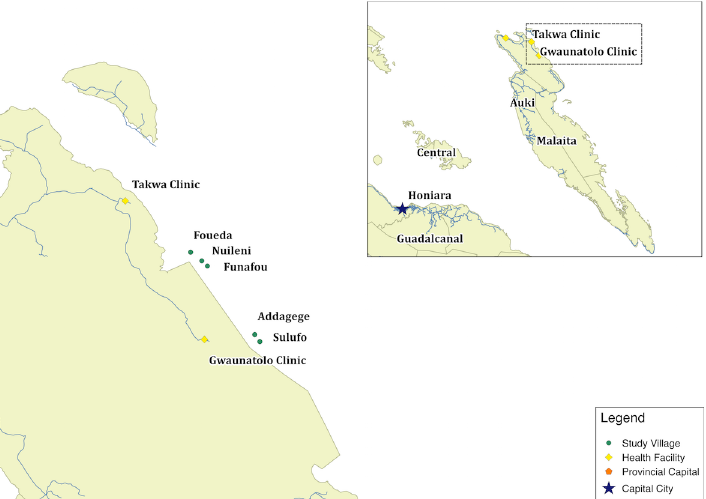
Fig 1. Location of villages. The map highlights the position of the five villages included in the original scabies control programme. Local health clinics and the provincial capital Auki are also shown.